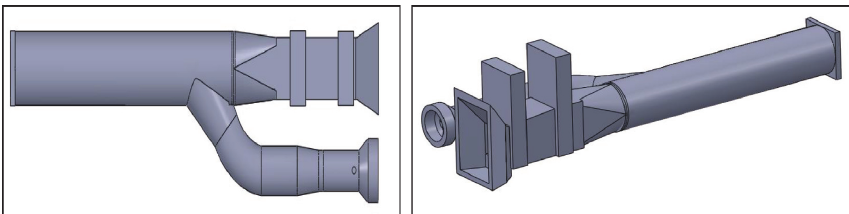
Figure 3: Complete bottom outlet geometry with Howell Bunger valve, aerator, and butterfly valve made in SolidWorks software.